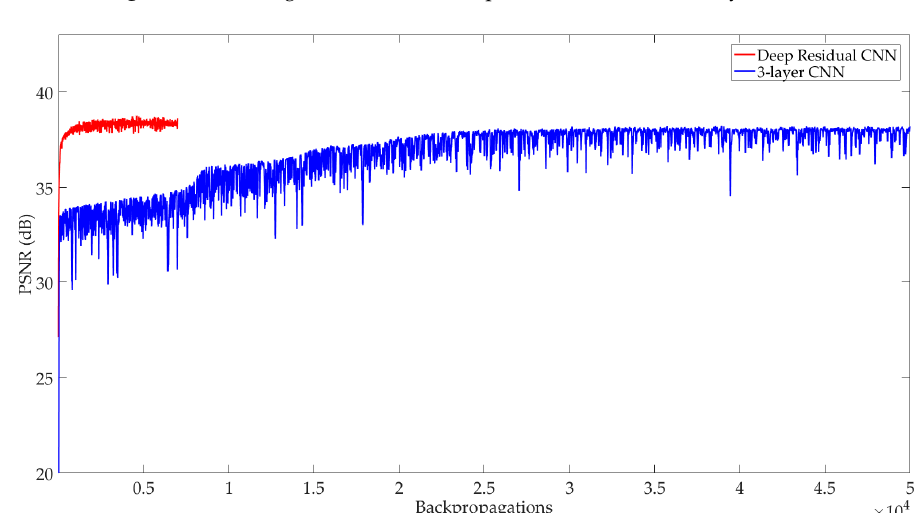
Figure 14. Testing PSNR curves for deep residual CNN and 3-layer CNN.